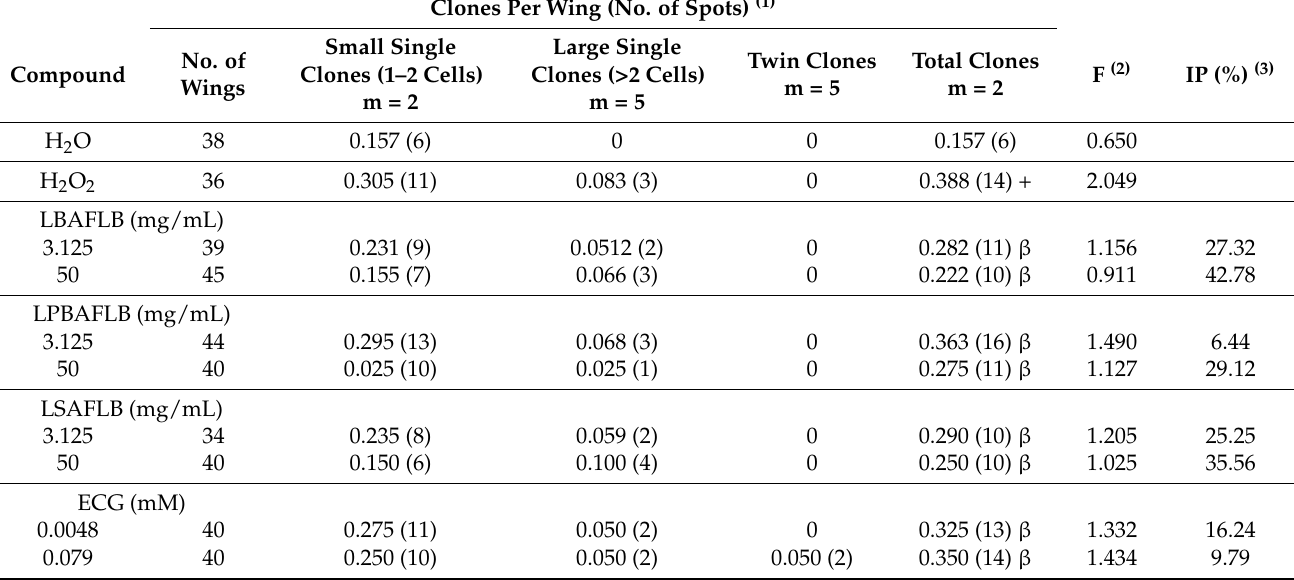
(1) Statistical diagnosis according to Frei and Wurgler [43]. β (significantly different) versus positive control. m: multiplication factor. Kastenbaum–Bowman Test without Bonferroni correction, probability levels α = β = 0.05. (2) Frequency of clone formation per 10 5 cells: clones/wings/24,400 cells. (3) The inhibition percentage for the combined treatments was calculated from total spots per wing according to Abraham